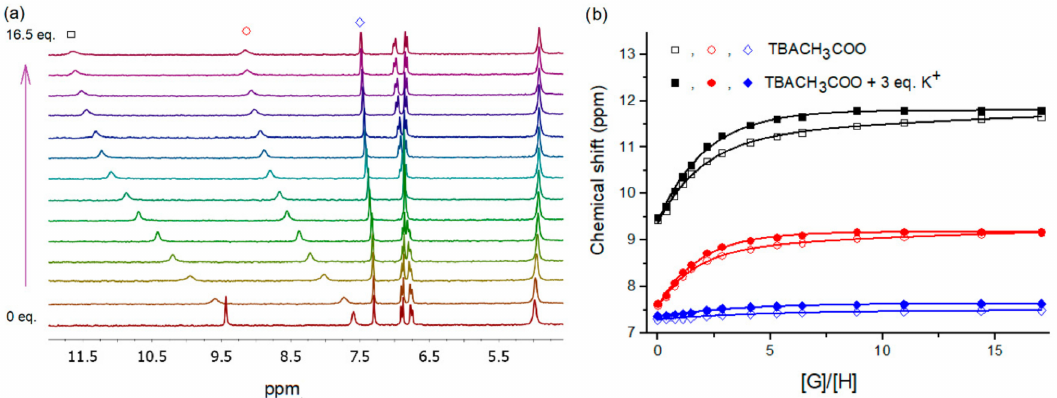
Figure 2. Representative stack plots of partial 1 H NMR spectra of 1 upon addition of TBACH 3 COO in DMSO- d 6 ( a ) and selected binding isotherms of receptor 1 ( b ) for TBACH 3 COO alone and with the presence 3 equiv. KPF 6